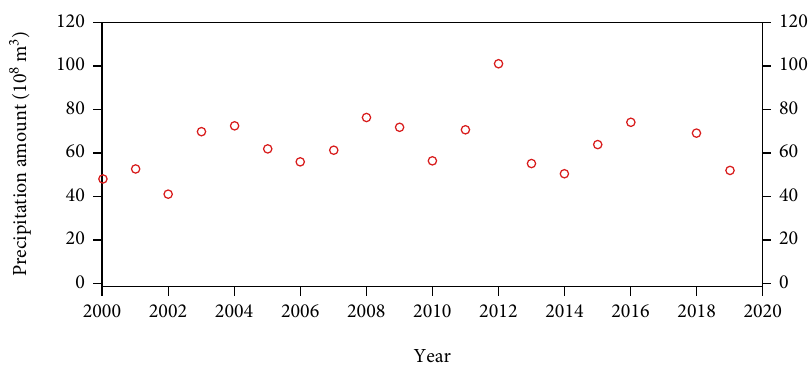
Figure 9: Precipitation amount of Tianjin City. Data comes from Tianjin Water Resources Bulletin ( Ministry of Water Resources website ), and only since the year 2000, there are available records online.